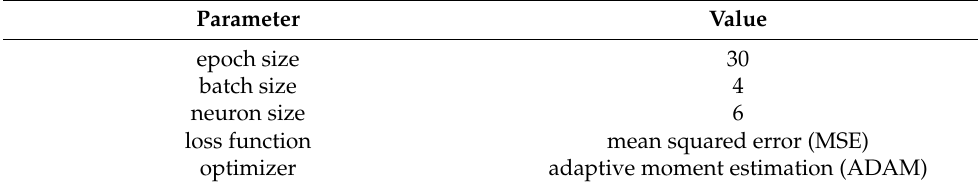
Table 3. The hyper-parameters of the LSTM network model (with one hidden